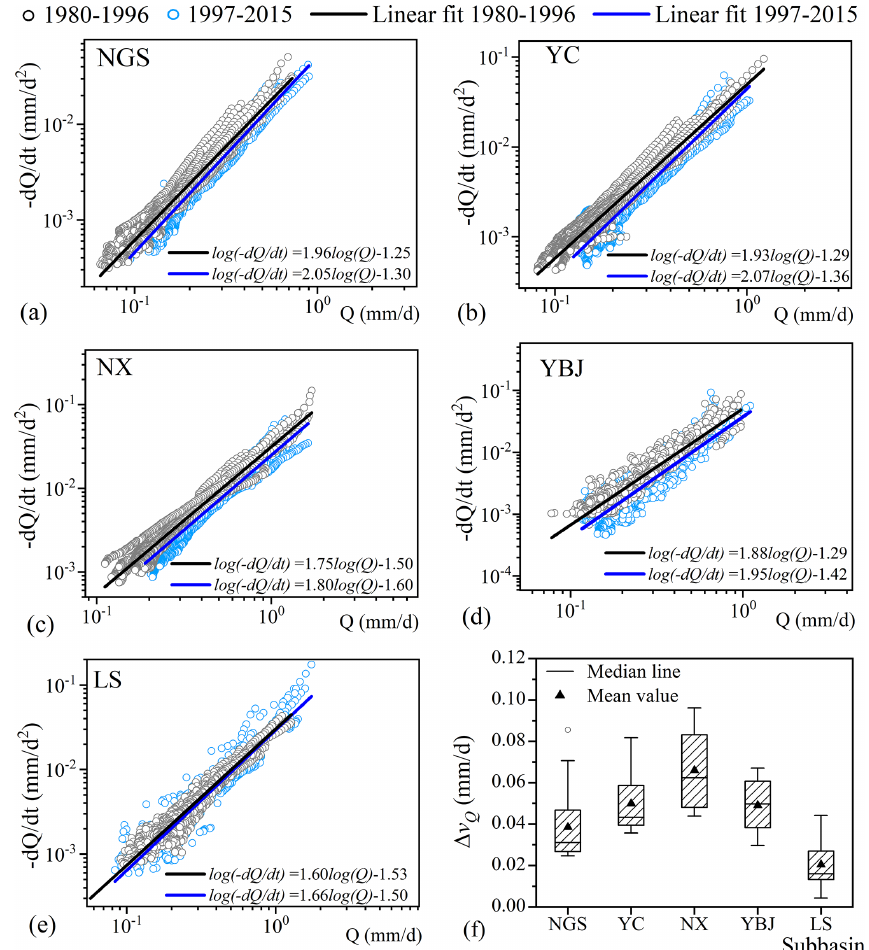
Figure 5. (a–e) Plot of − d Q/ d t vs. Q in log–log diagram for each recession hydrograph during 1980–2015 and the fitting lines [log ( − d Q/ d t) = b log (Q) + log (a) ] for the data points in the two periods for the five subbasins. (f) Differences in mean recession rates between the two periods ( (cid:49)v Q ) estimated from the non-overlapping moving averages of the 5d series.